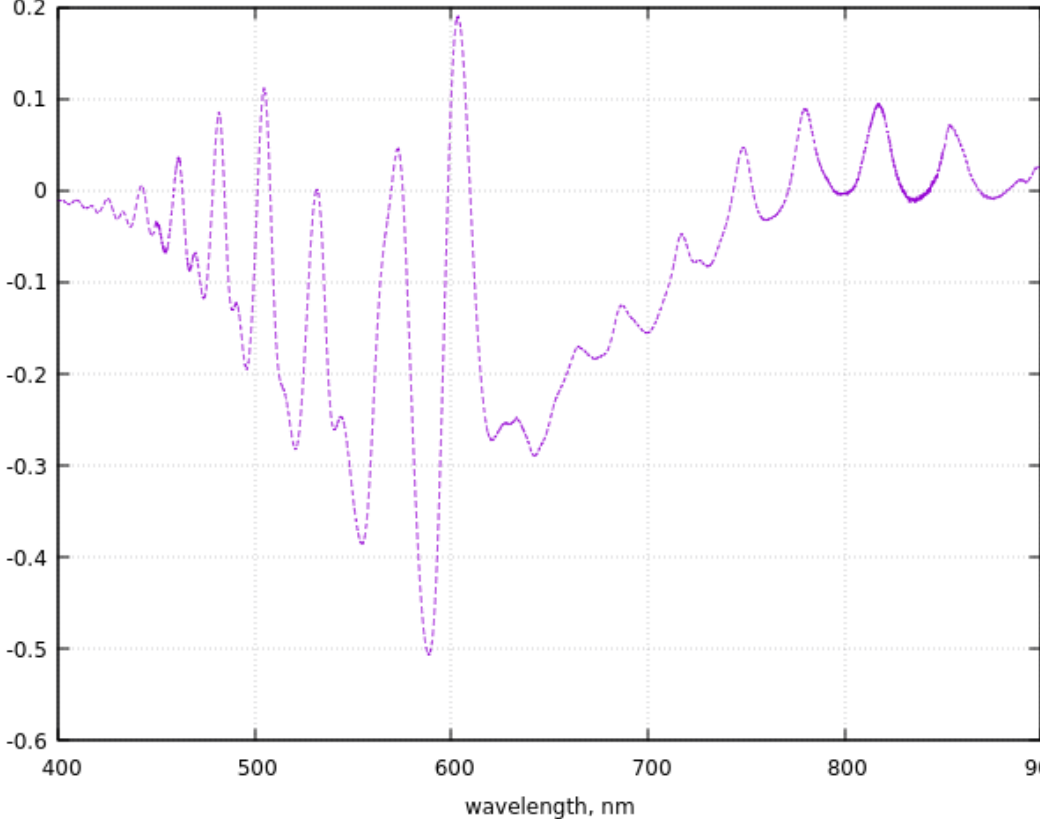
Figure 3. The ozone transmittance error.